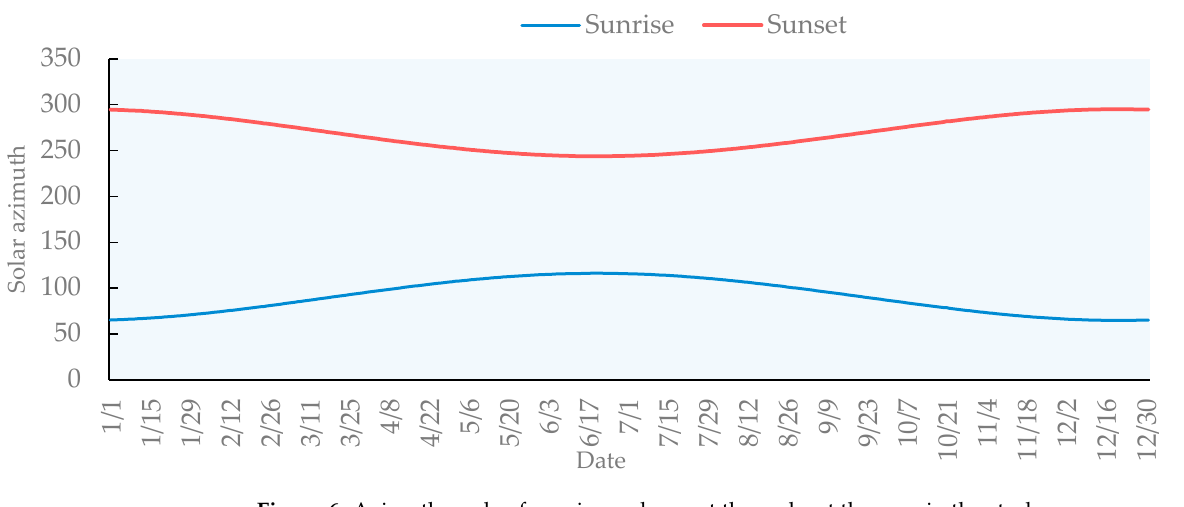
Figure 6. Azimuth angle of sunrise and sunset throughout the year in the study area. As can be seen from Table 6, the best sunrise viewing period is from 5 a.m. to 7 a.m., and the sunset viewing period is from 5 p.m. to 7 p.m. The number of sample plots falling into the viewing area is 21, among which 12 are for sunrise viewing in spring and 10 are for sunset viewing. In summer, eight sites were used to watch the sunrise and six for the sunset. In autumn, six sites were used to watch the sunrise and five for the sunset. In winter, there were five sites used for sunrise viewing and six for sunset viewing. Sunset observation points 18, 1, and 2 appeared with high frequency, while sunset observation points 14, 21, 25, and 26 appeared with high frequency. Table 6. Timetable of sunrise and sunset positions in different